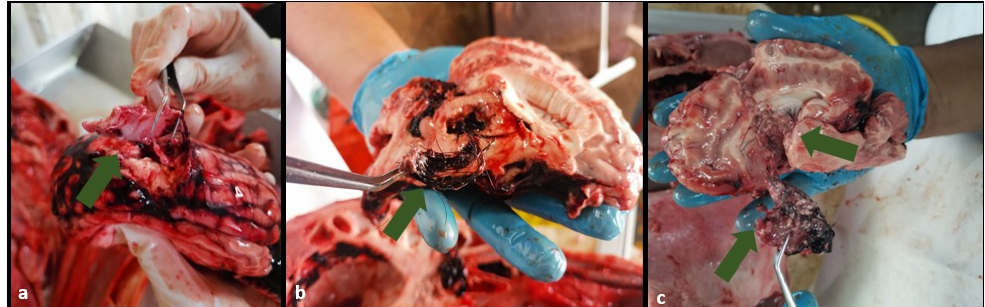
Figure 5. Heads of water buffaloes stunned at the first shot in the proposed area with their evident degree of damage at the level of the cerebral hemisphere. Massive destruction of brain tissue with abundant hemorrhage is observed ( a ); cerebral hemorrhage and malformation of fornix with evi- dence of hide segment in thalamus ( b ).